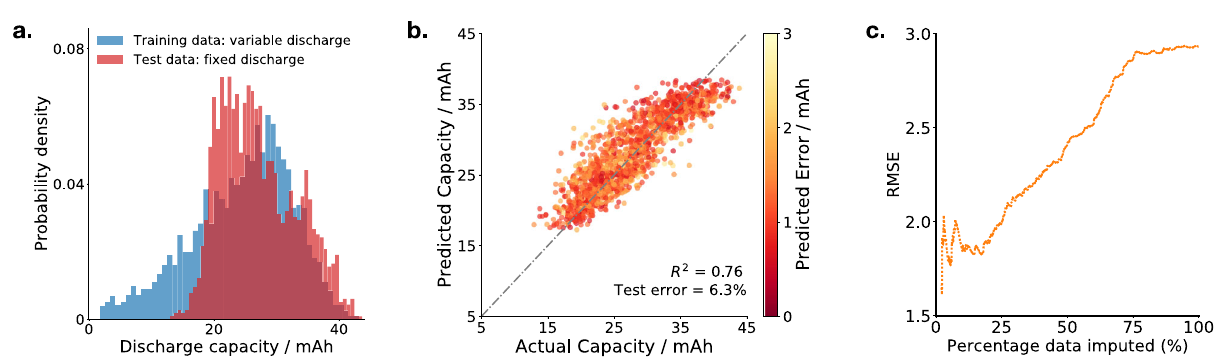
Fig. 6 | Robustness to domain shift. a The distribution of discharge capacity is different for cells cycled under variable dischargerates (blue) compared to a fi xed discharge rate (red); the overlap region of the two distributions appears darker in colour. b Our model, trained on the variable discharge rate cells, accurately pre- dicts the discharge capacities of cells cycled under a fi xed discharge rate. The